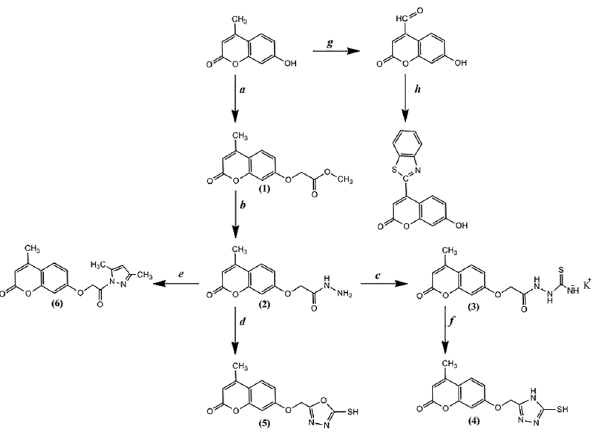
Fig 1. Reaction sequences of the synthesized compounds. a = Methyl bromoacetate; b = Hydrazine; c = KSCN; d = CS 2 ; e = acetylacetone; f = KOH; g = SeO 2 ; h = o-aminothophenol